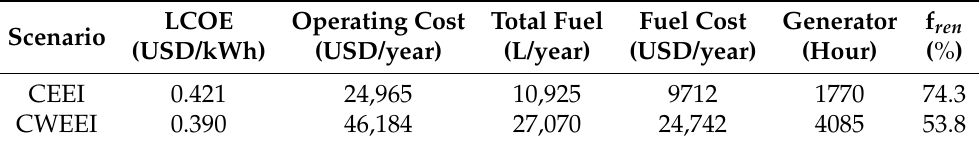
Table 7. Operational and economic values for the CEEI and the CWEEI over the planning horizon with fuel price of 0.93